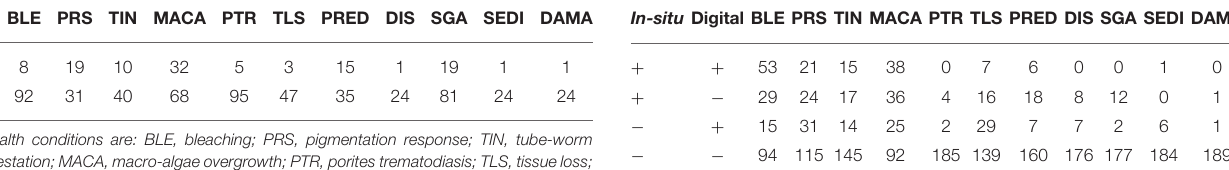
TABLE 1 | Hyperparameters for the independent Beta( α , β ) priors on health condition prevalences, π k .